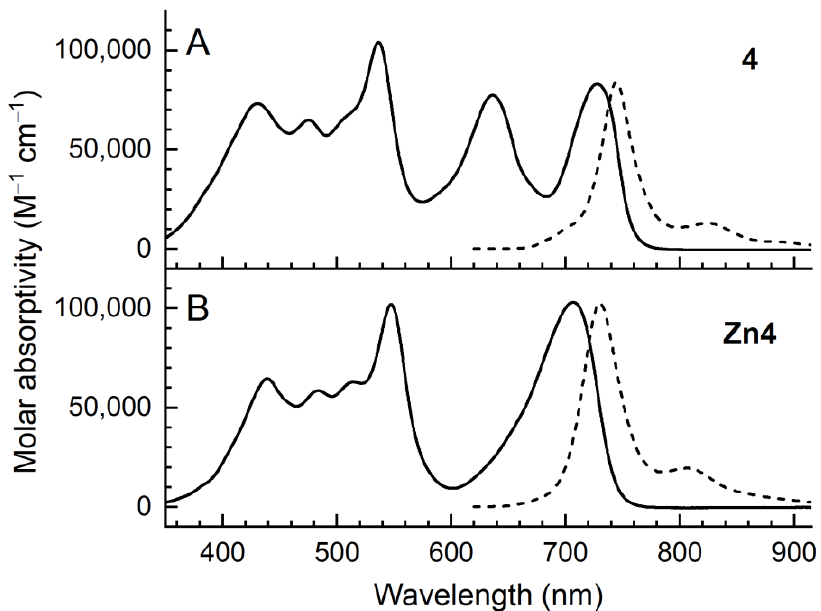
Chart 1. Structure of panchromatic triad ( 4 ) and the zinc chelate Zn4 .